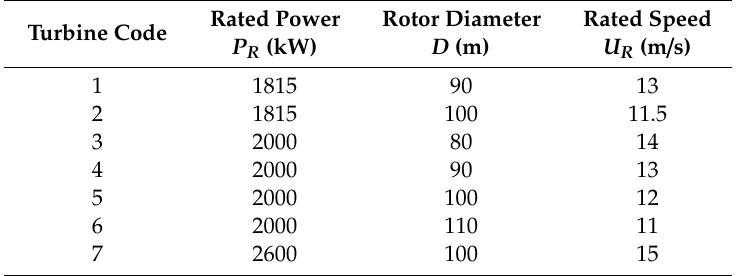
Table 1. Code, rated power, rotor diameter, and rated speed for the turbines included in the selection. Turbine